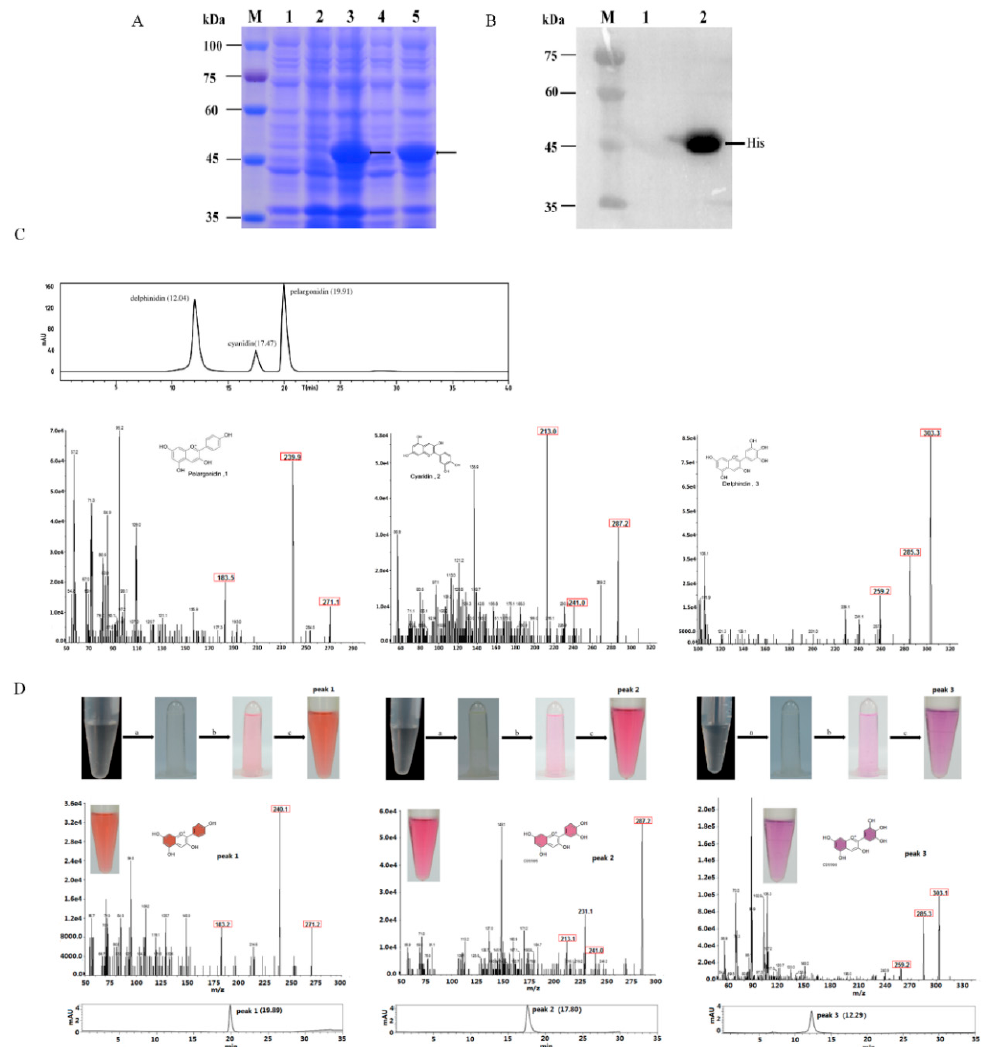
Figure 2. SDS-PAGE analysis and enzyme activity assay of the His-tagged MaDFR protein. ( A ) Coomassie brilliant blue stained polyacrylamide gel. M, protein marker. Lane 1, total protein extract of E. coli BL21 (DE3) harboring the empty pET-28a expression vector. Lane 2, total protein extract of E. coli BL21 (DE3) containing the expression plasmid pET-28a-MaDFRbefore induction. Lane 3, total protein extract of E. coli BL21 (DE3) containing the expression plasmid pET-28a-MaDFR after induction. Lane 4, the bacterium containing crude proteins extract of E. coli BL21 (DE3), containing the expression plasmid pET-28a-MaDFR after induction. Lane 5, the supernatant containing crude protein extract of E. coli BL21 (DE3), containing the expression plasmid pET-28a-MaDFR after induction. ( B ) Western blot analysis of the His-tagged DFR protein. M, Protein marker. Lane 1, negative control. Lane 2, MaDFR protein. ( C ) HPLC − MS/MS analysis of the standards of pelargonidin, 1; cyanidin, 2; and delphinidin, 3. The concentrations of these standards was 1000 ng/ mL. ( D ) HPLC − MS/MS analysis of MaDFR reaction products. Enzymatic reaction process of three substrates, the substrate of peak1 is dihydrokaempferol (DHK), the substrate of peak2 is dihydroquercetin (DHQ), and the substrate of peak3 is dihydromyricetin (DHM). a. A 500 µL reaction mixture containing 70 µL (10 mM) Tris-HCl (pH 7.0), 50 µL (20 mM) NADPH, 370 µL crude protein extract containing MaDFR and 10 µL of DHK, DHQ and DHM, respectively, was incubated at 37 °C for 1 h; next, an equal volume of n-butanol:HCl (95:5, v / v ) was added. b. The reactions were incubated at 95 °C for 1 h to form anthocyanidins. c. the n-butanol layer was evaporated using a stream of nitrogen gas and the residue was dissolved in 100 µ L of methanol. Numbers in brackets indicate retention times. Numbers in red boxes indicate the major fragment